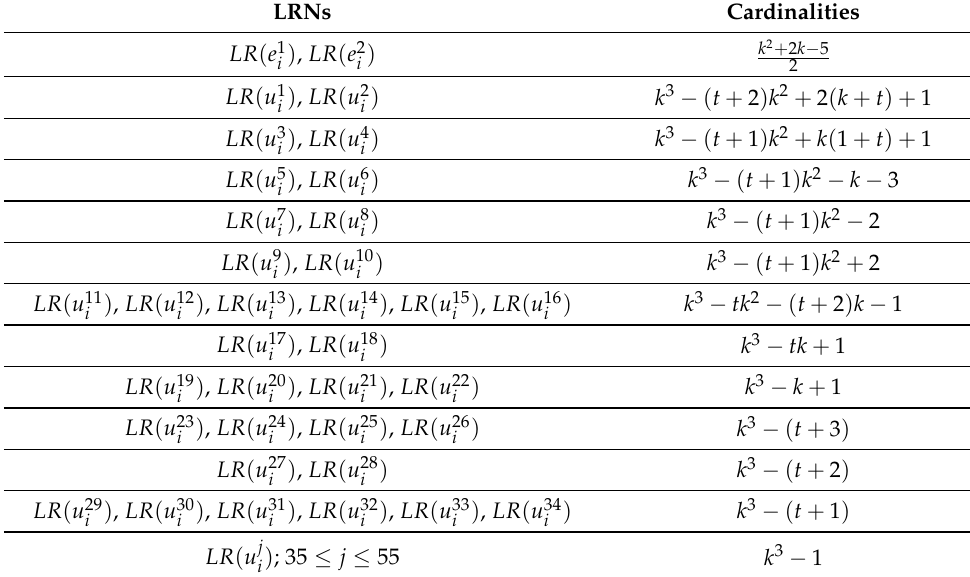
) for 1 ≤ y ≤ 2 and LR ( u z i